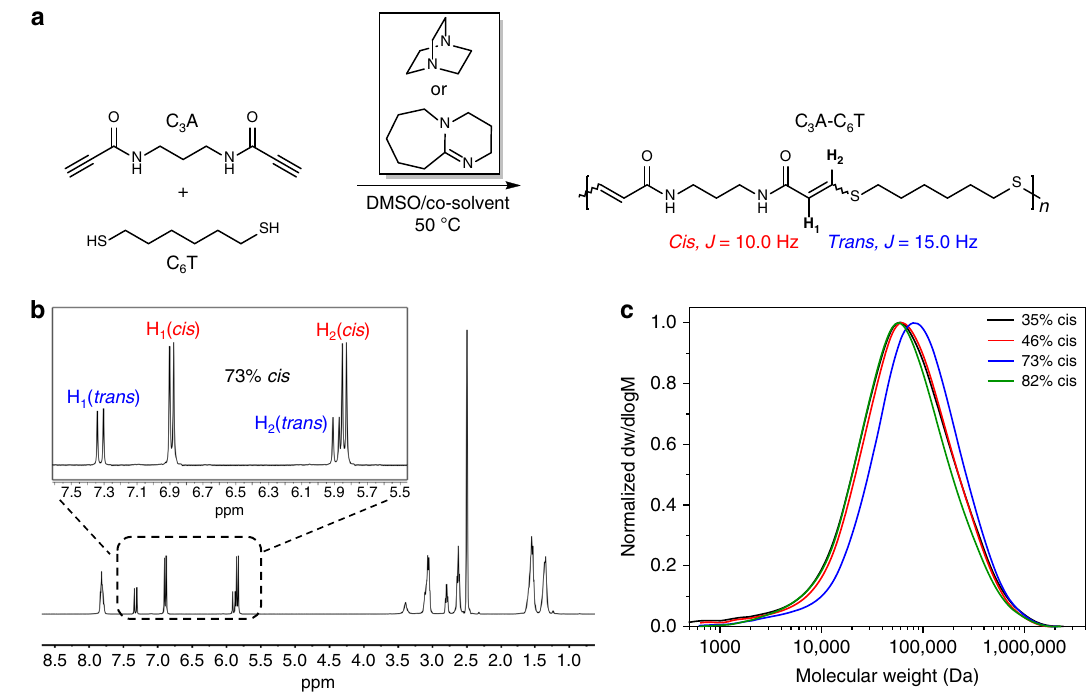
Fig. 1 Characterisation of stereocontrolled polyamides. a Step-growth polyaddition reaction between C 3 A and C 6 T to furnish unsaturated polyamides (C 3 A-C 6 T). b Representative 1 H NMR spectrum (DMSO – d 6 , 25 °C, 400 MHz) of C 3 A-C 6 T (73% cis content) from using DMSO and DBU. Cis and trans proton resonances were assigned by coupling constants. c SEC (DMF, 0.5 % w/w NH 4 BF 4 ) chromatograms determined against poly(methyl methacrylate) (PMMA) standards for polyamides with various stereochemistry.